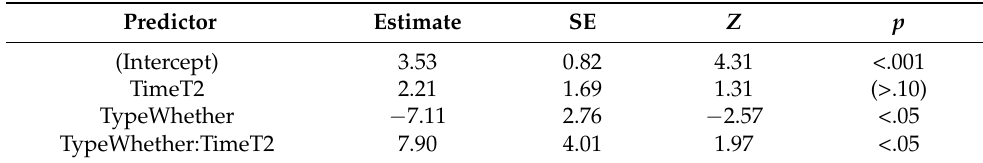
Table 2. Table of fixed effects for Experiment